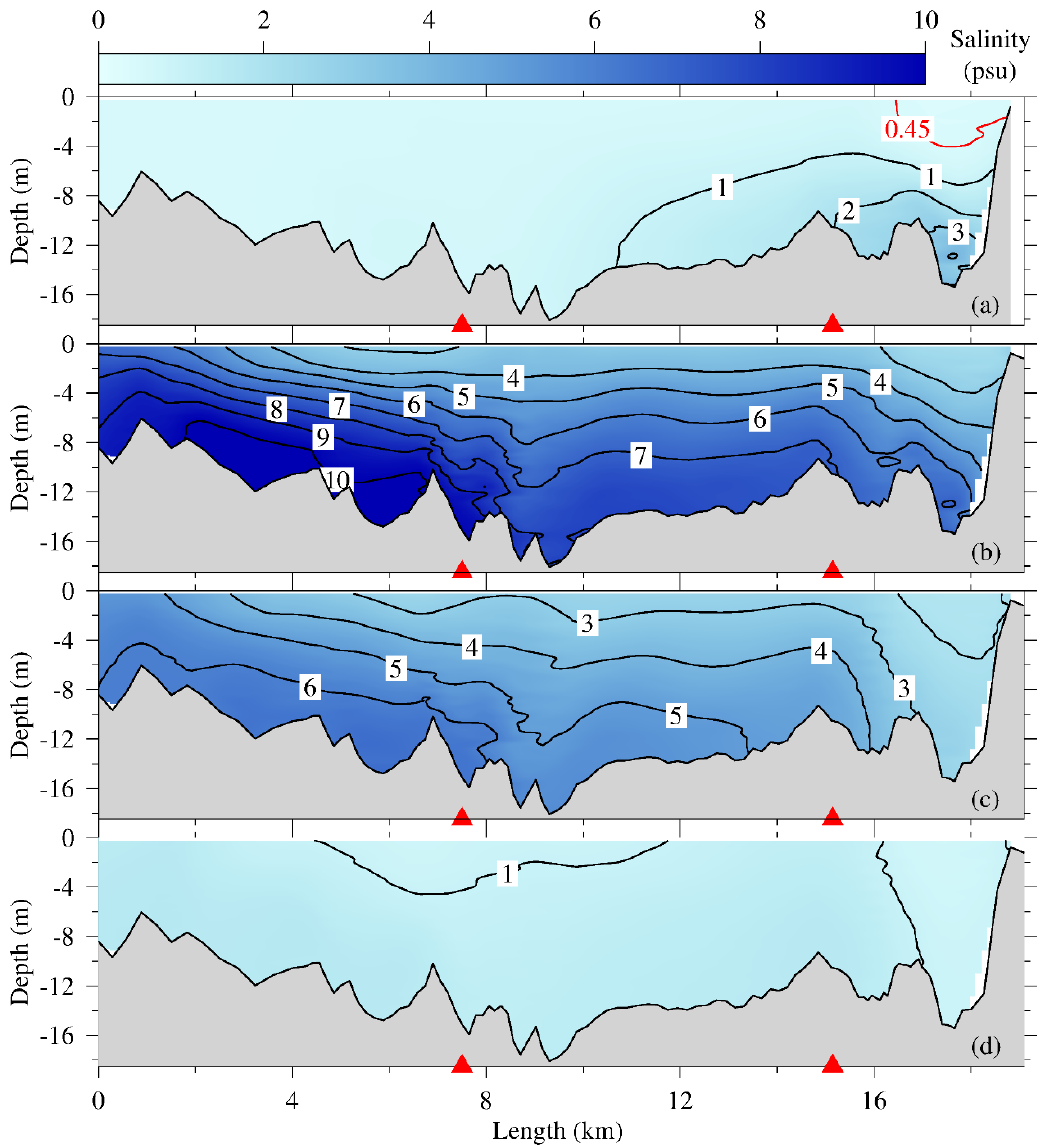
Figure 13. Distributions of the tidally averaged salinity along Sec.6 during neap tide ( a ), middle tide after neap tide ( b ), spring tide ( c ) and middle tide after spring tide ( d ) in EX2. Red triangle: the northern (left) and southern (right) inlets of the HC.